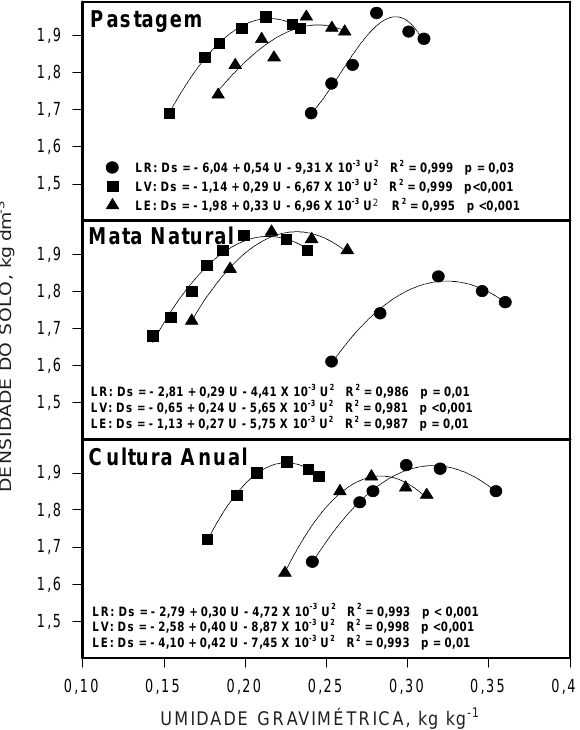
Figura 1. Curvas de compactação para a pastagem, mata natural e cultura anual em um Latossolo Vermelho-Amarelo, Latossolo Vermelho-Escuro e Latossolo Roxo.